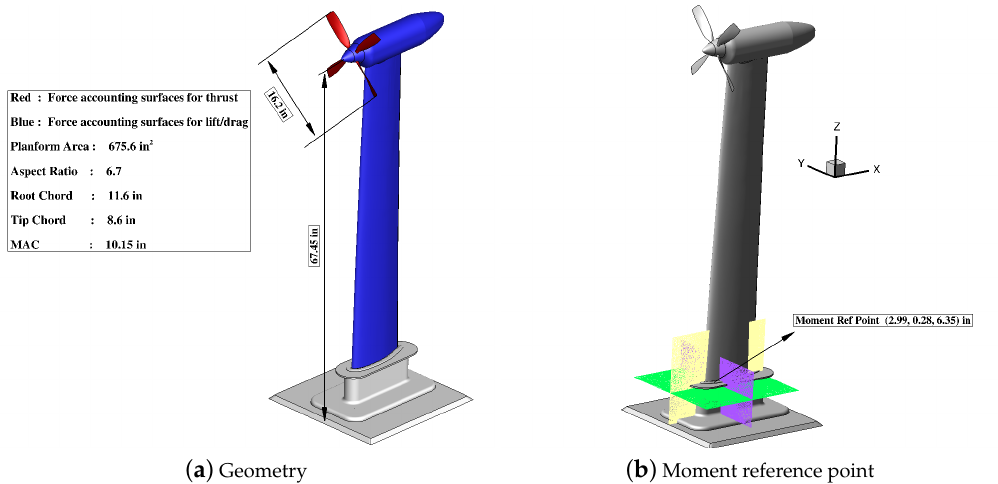
Figure 1. Workshop for Integrated Propeller Prediction (WIPP) test case and moment reference